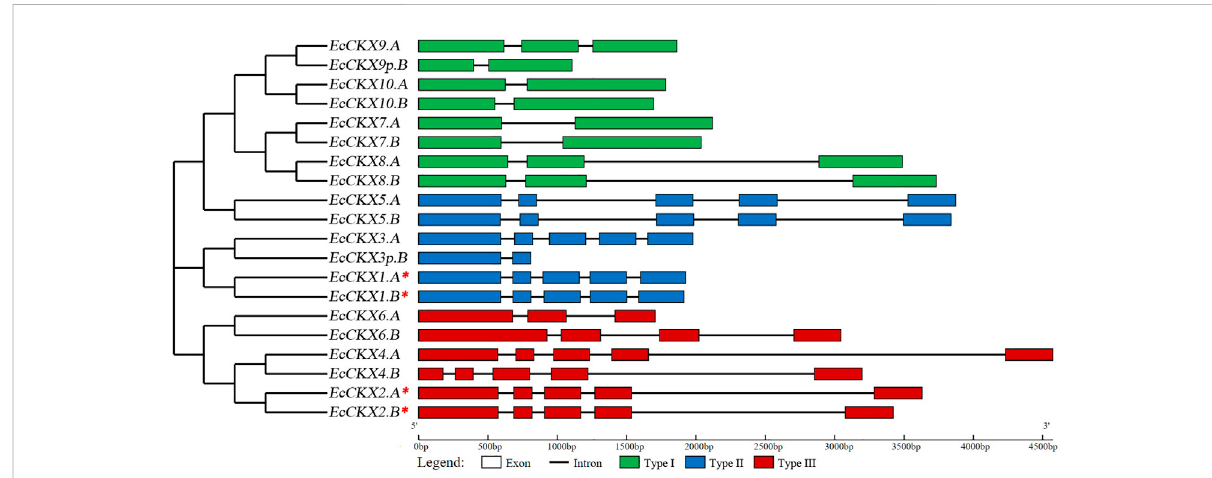
FIGURE 1 Exon-intron structure of the identi fi ed CKX genes within the E. coracana genome. The NJ phylogenetic tree was constructed with bootstrap supportof1,000iterations(allbrancheshadsupportof65%andhigher),basedoncdssequencesoftheidenti fi edgenes.Aredasterixdenotesgenes identical to previously sequenced and characterized EcCKX1 and EcCKX2 .